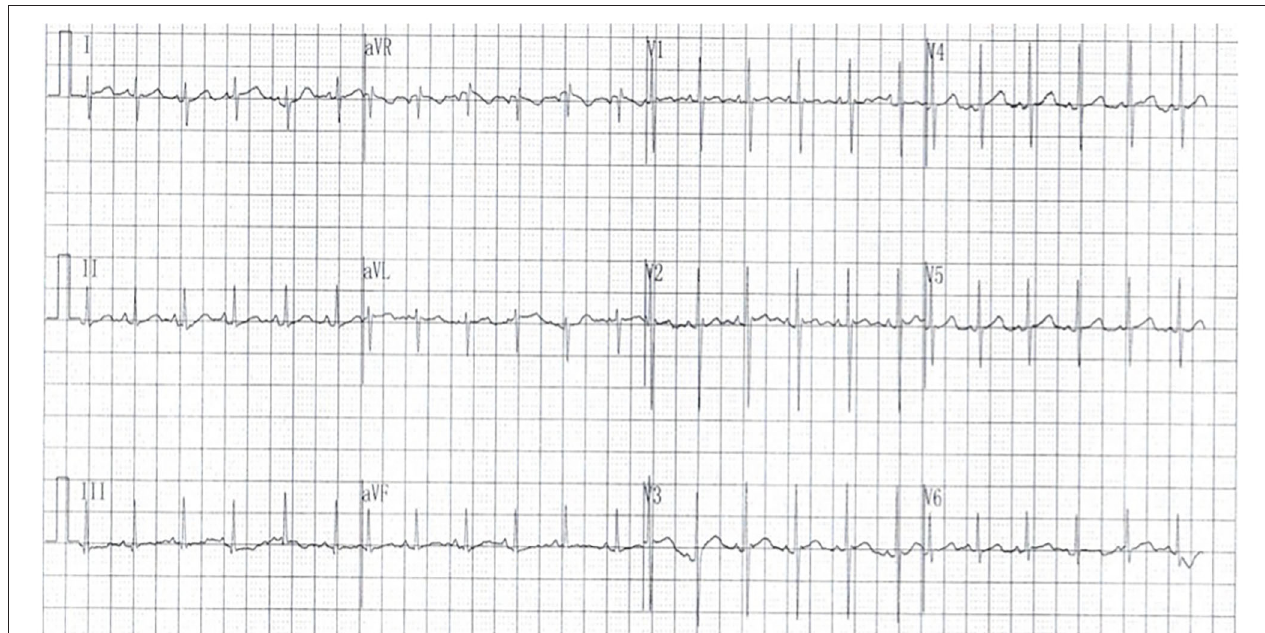
FIGURE 3 | The 12-lead electrocardiogram showed sinus rhythm with a normal QRS duration of 62ms, and a QRS axis of 72 ◦